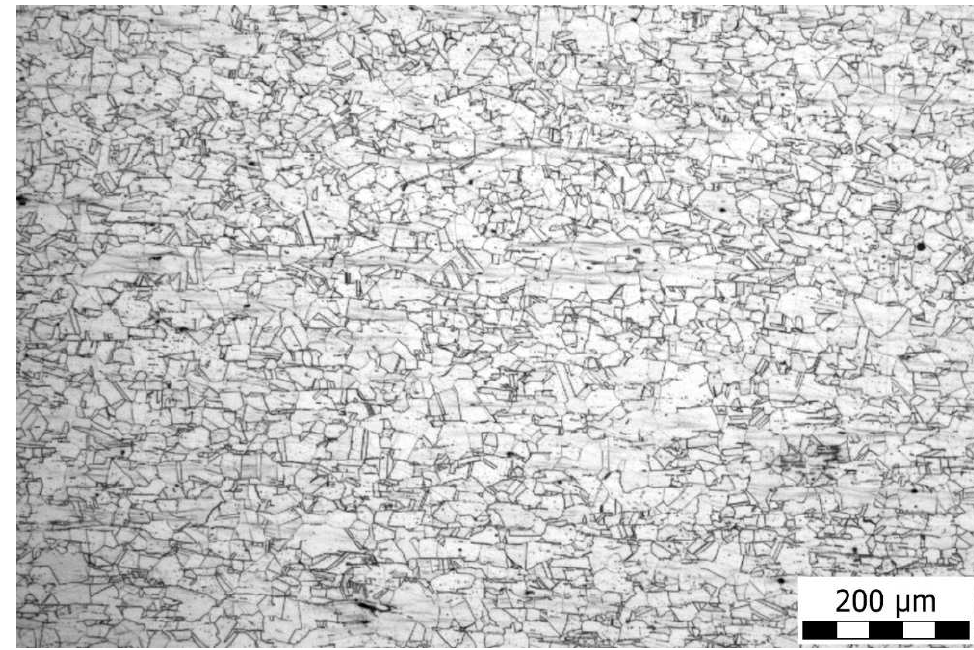
Figure 11. Microstructure of hot-rolled austenite plate.